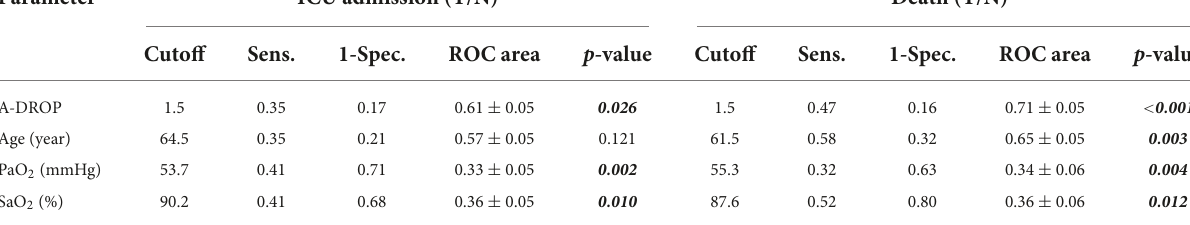
TABLE 3 Determinants of ICU admission and death.